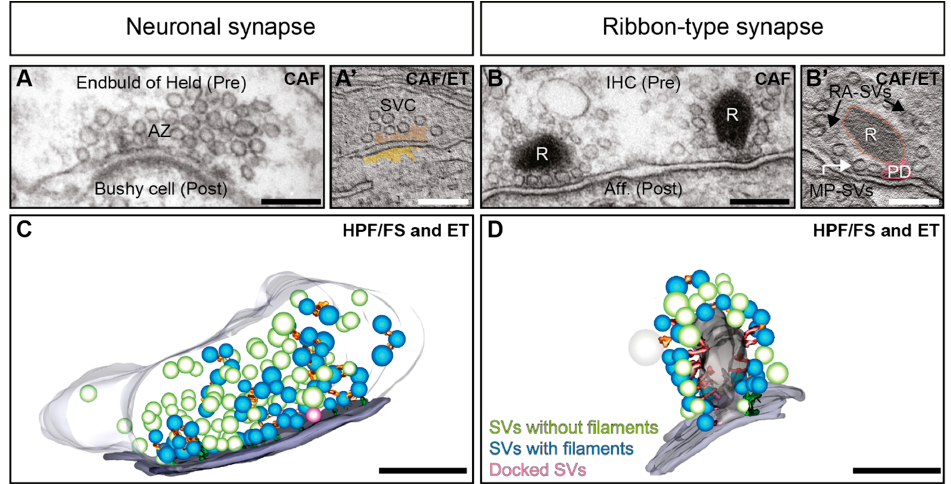
Figure 1. The nanoarchitecture of an excitatory neuronal and ribbon-type synapses. ( A ) Electron micrograph of an individual active zone (AZ) from a mature murine endbulb of Held (presynaptic compartment, Pre) in the anteroventral cochlear nucleus projecting onto a Bushy cell (postsynaptic compartment, Post). ( B ) Electron micrograph of ribbon (R) synapses formed by inner hair cells (IHC, Pre) and a ff erent fibers (A ff ., Post). ( A’ ) Example virtual section obtained from electron tomography